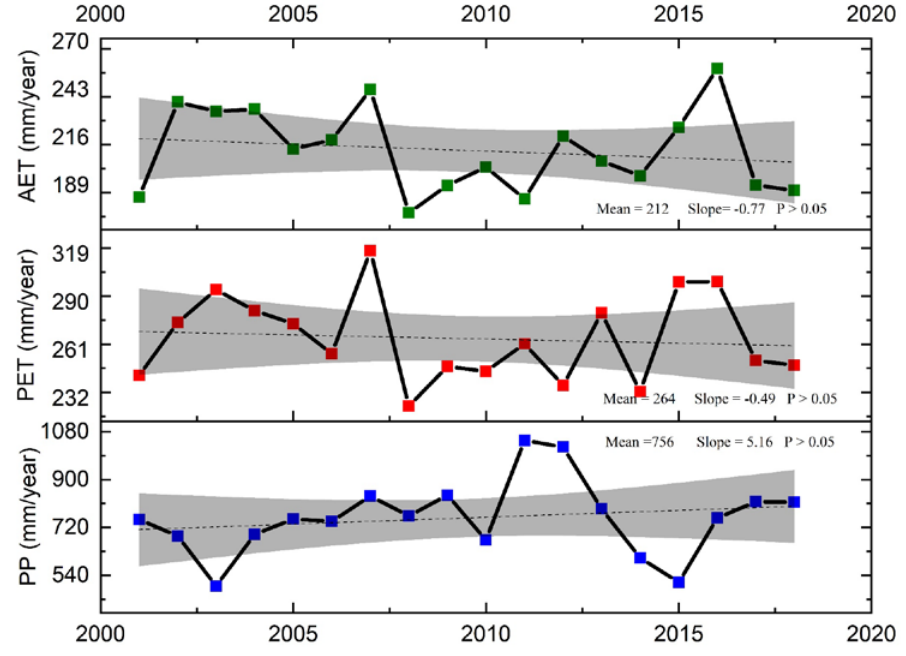
Figure 4. Time series of the natural lands global annual mean for AET, PET, and PP.